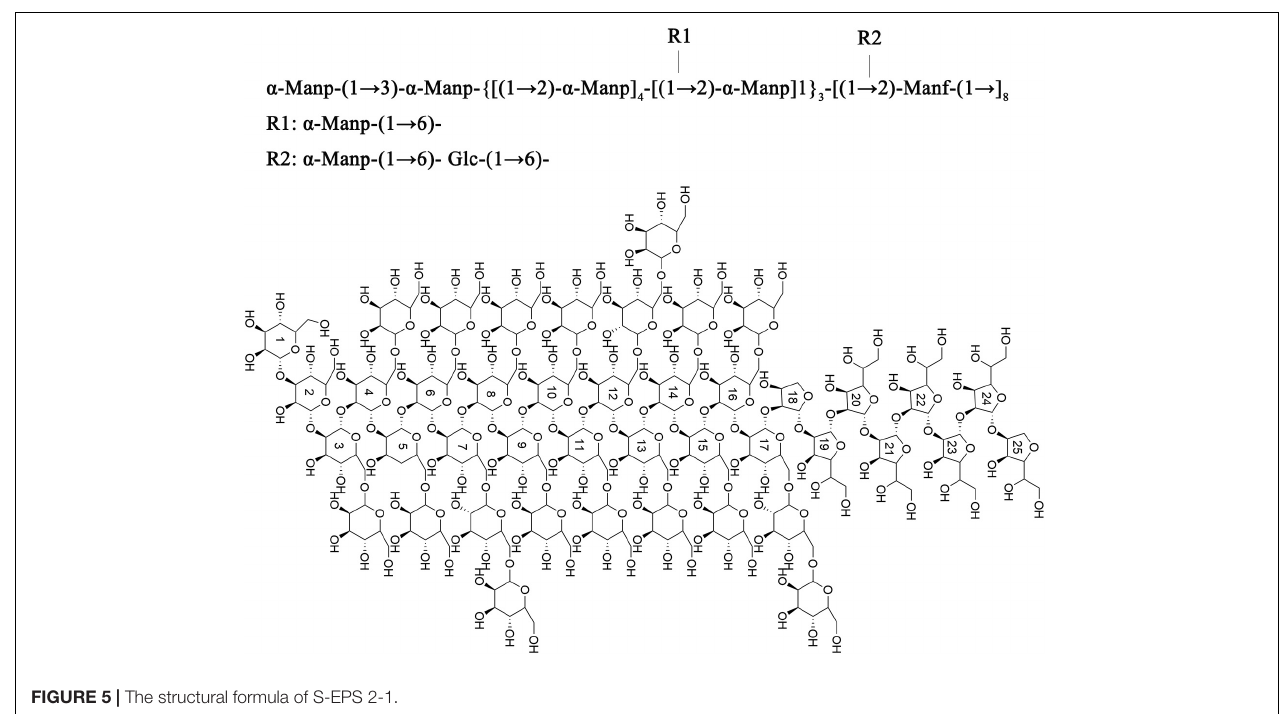
FIGURE 5 | The structural formula of S-EPS 2-1.